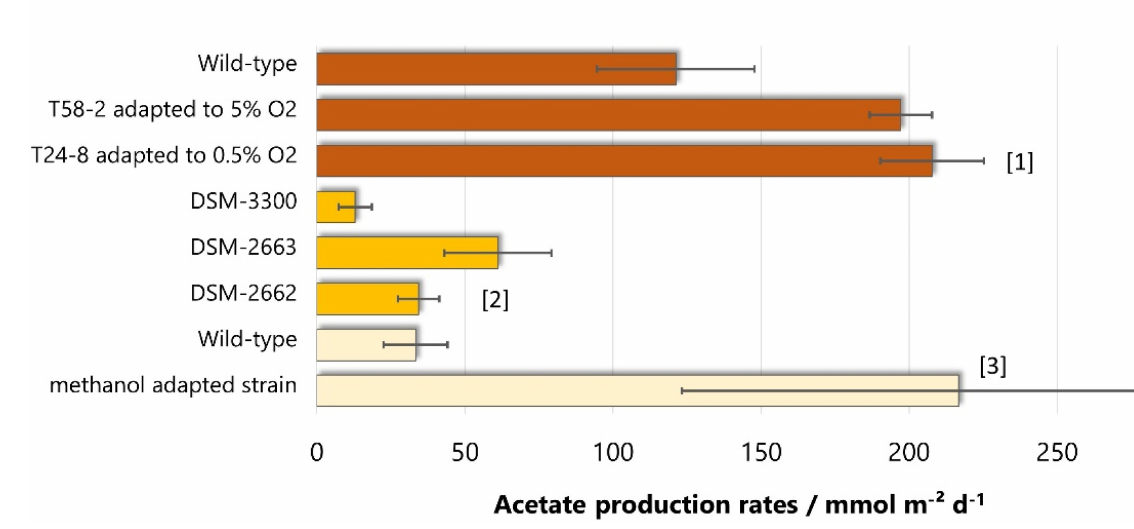
FIGURE 3 | Acetate production rates of different S. ovata strains. Bars of the same color are derived from the same studies: [1]: (Shi et al., 2021), [2]: (Aryal et al., 2017b), [3]: (Tremblay et al., 2015). On that basis, results of the same color are directly comparable, as other parameters (cathode potential, medium, biofilm immobilization, reactor configuration) are not